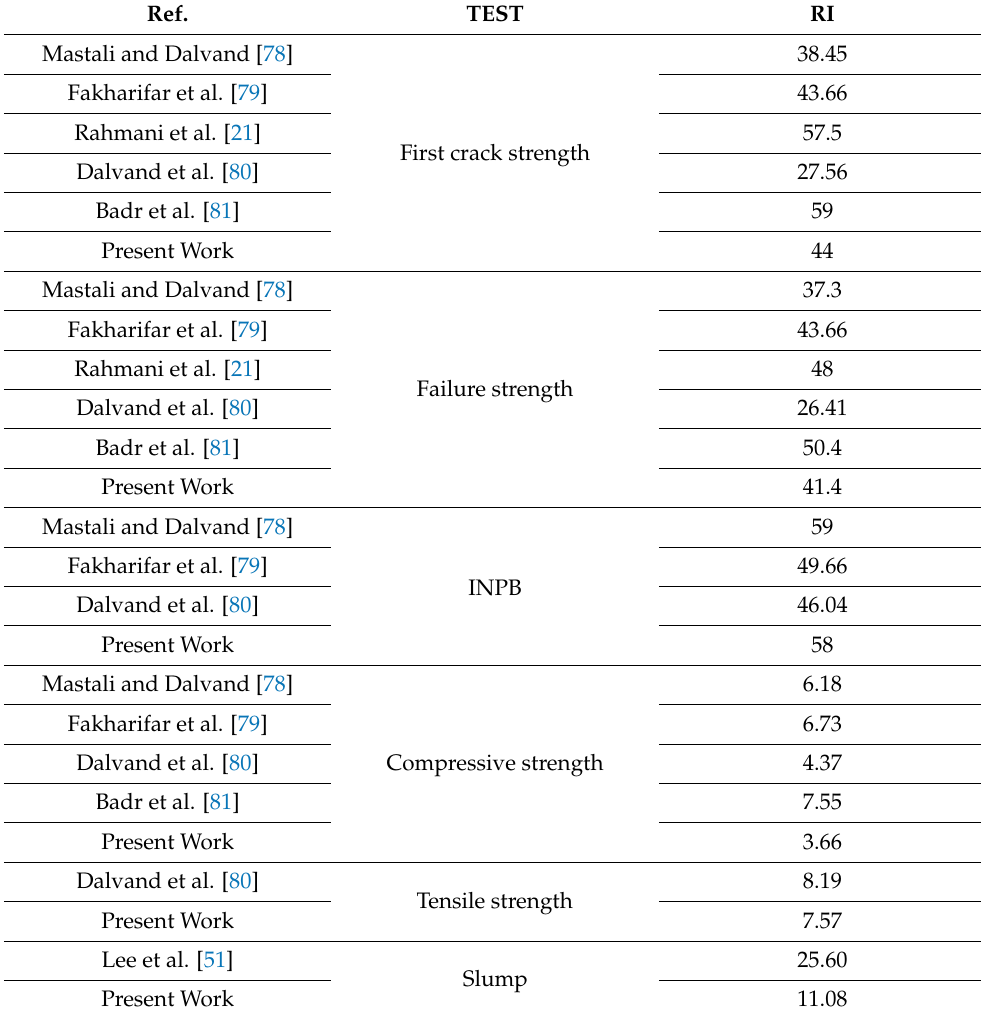
Table 7. Repeatability test results for previous studies and the present study.